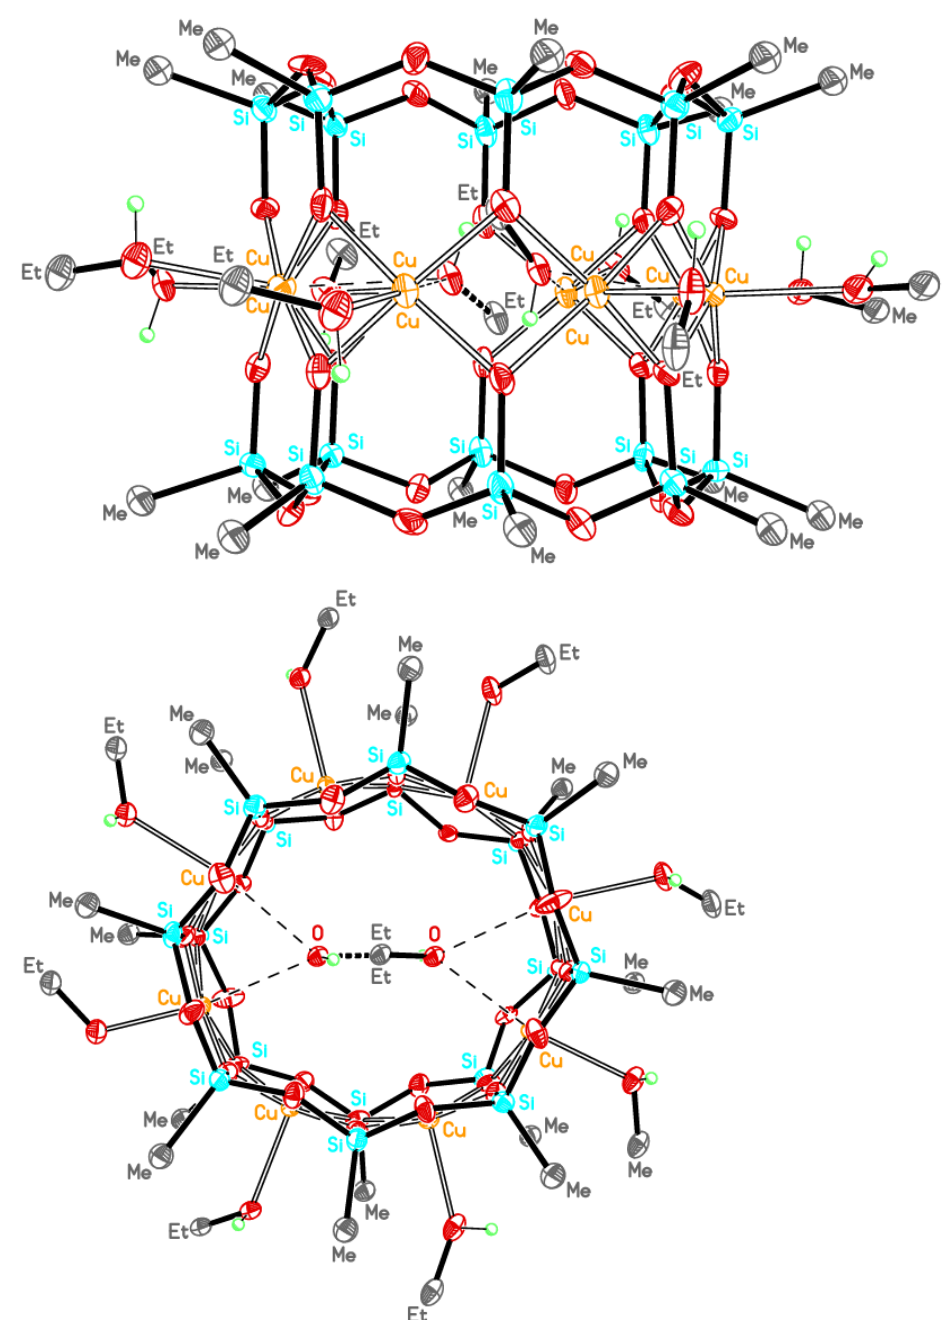
Figure 1. Two projections of molecular structure of complex [(MeSiO 2 ) 8 ] 2 Cu 8 (DMF) 8 (EtOH)] • 2.75 (DMF) • 0.25 (Me 2 CO) 1 ; the solvate dimethylformamide and acetone molecules are not shown. Hydrogen atoms are presented as green dots (the same concerns Figures 2–6).